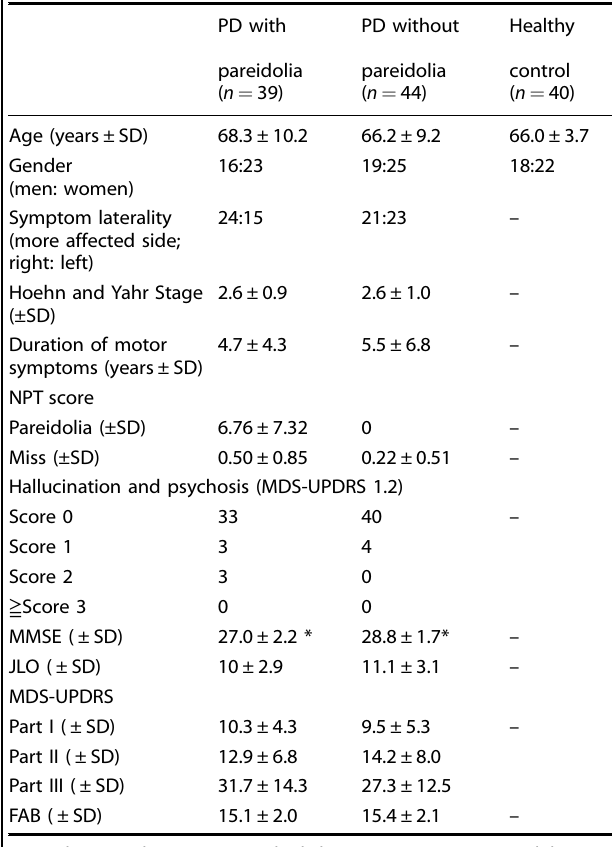
Table 1. Demographic characteristics and variables for patients with Parkinson ’ s disease with and without pareidolia ( n =